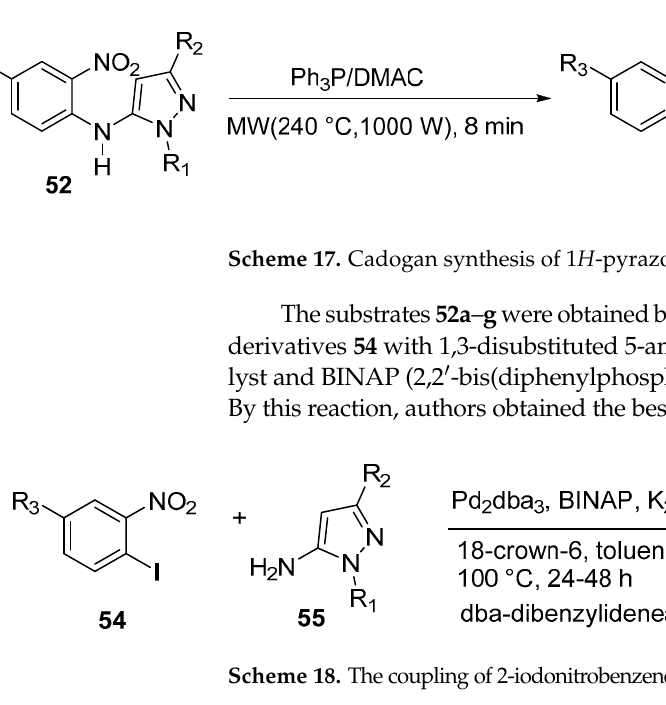
Table 9. The photophysical constants of the compounds 23e – g in different solvents.